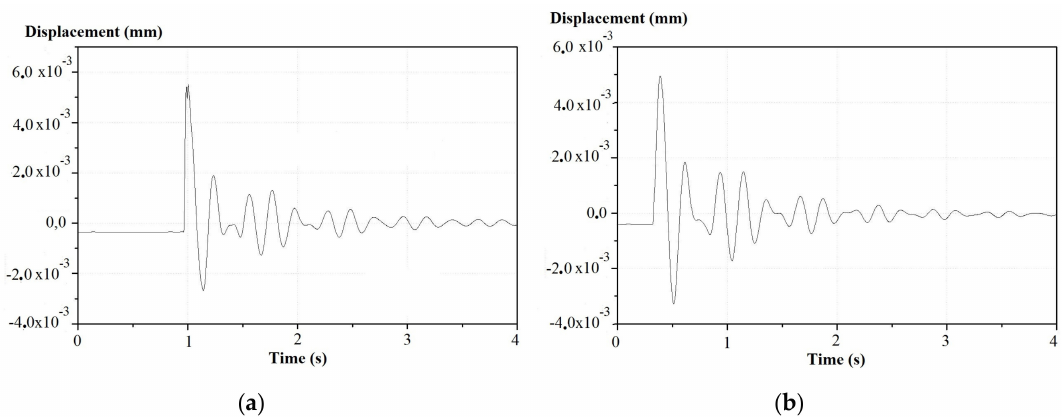
Figure 15. Displacement-time at the intrados middle section in the ( a ) un-reinforced and ( b ) reinforced beam.